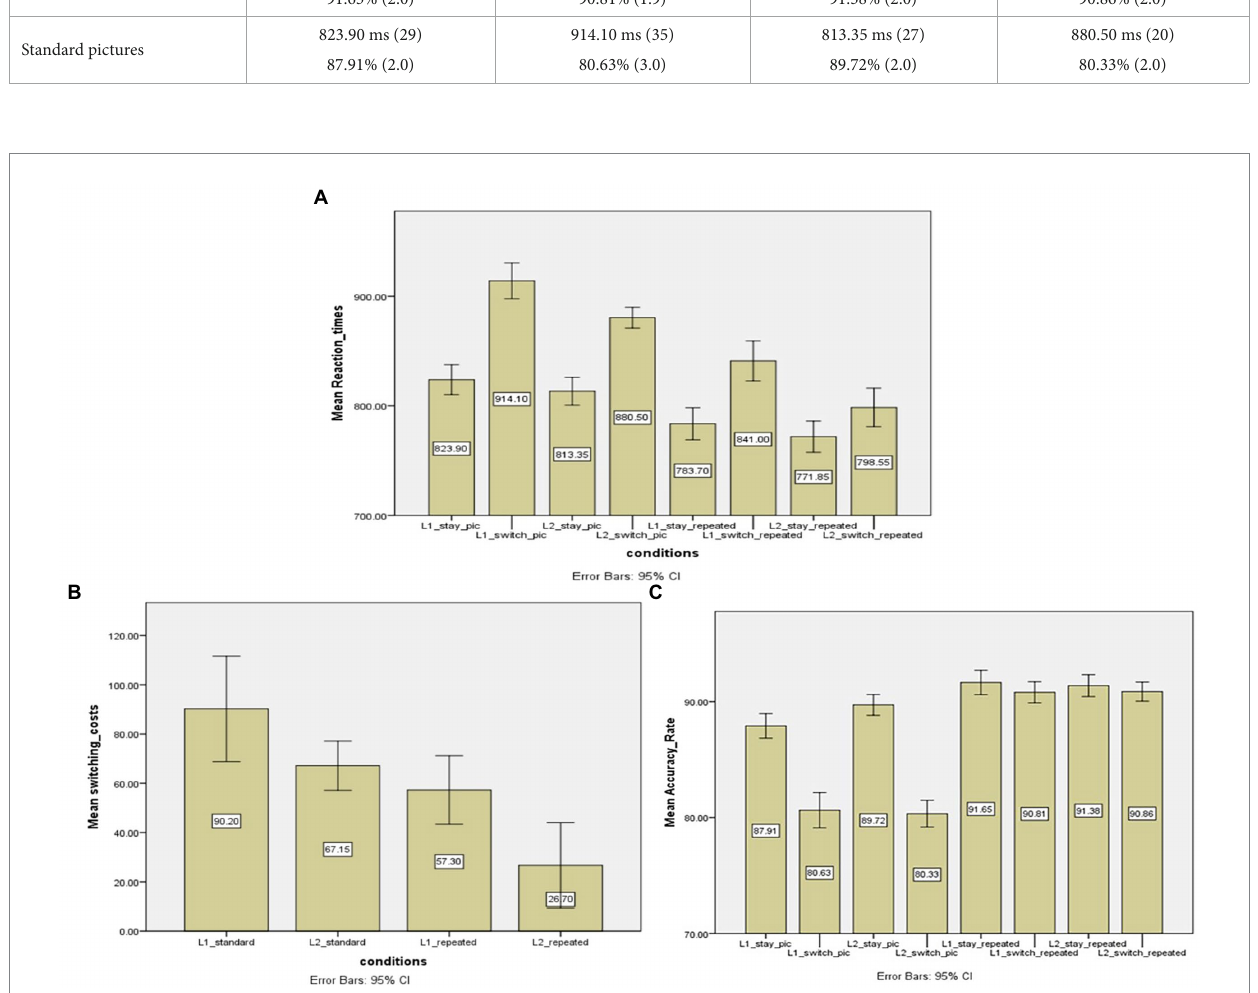
FIGURE 3 (A) Mean reaction times (in ms) of stay and switch trials across two stimulus conditions (standard vs. repeated pictures). (B) Switching costs (in ms) as a function of ‘response language’ (Chinese vs. English) and ‘stimulus type’ (standard vs. repeated pictures). (C) Mean accuracy rates (in percentage) of stay and switch trials across two stimulus conditions (standard vs. repeated pictures). L1 = the first language, L2 = the second language. Standard = the standard pictures, repeated = repeated